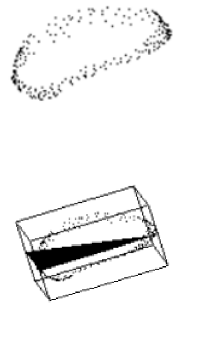
Fig. 10. Separated foot surface points.